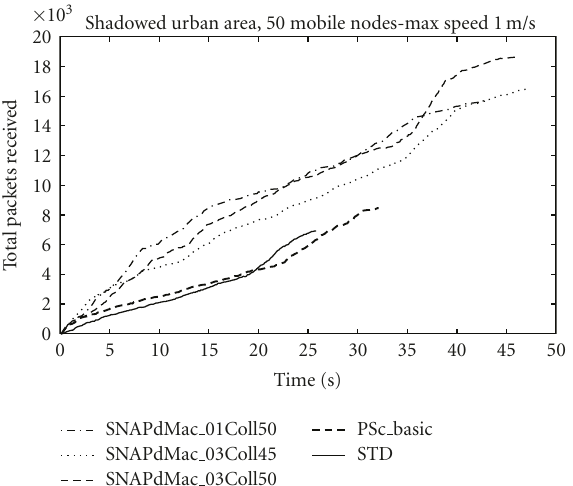
Figure 7: Total number of packets received; mobile network. Figure 8: High density/contention